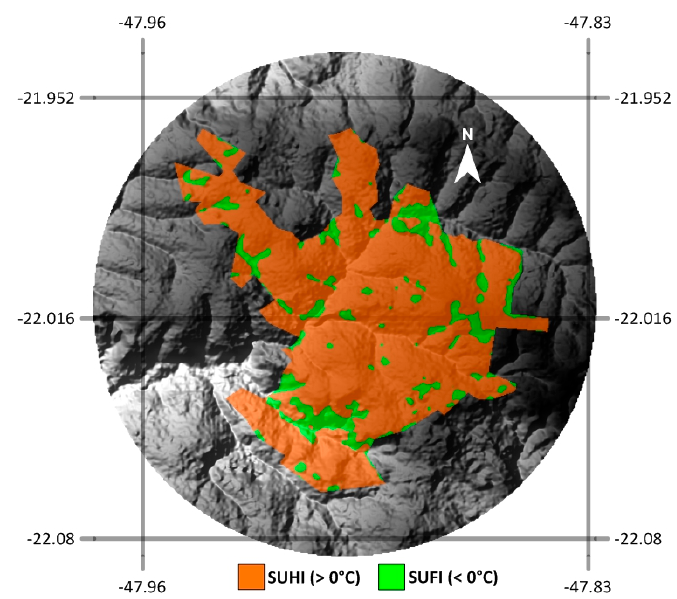
Figure 5. Area occupied by SUHI and surface urban freshness island (SUFI).